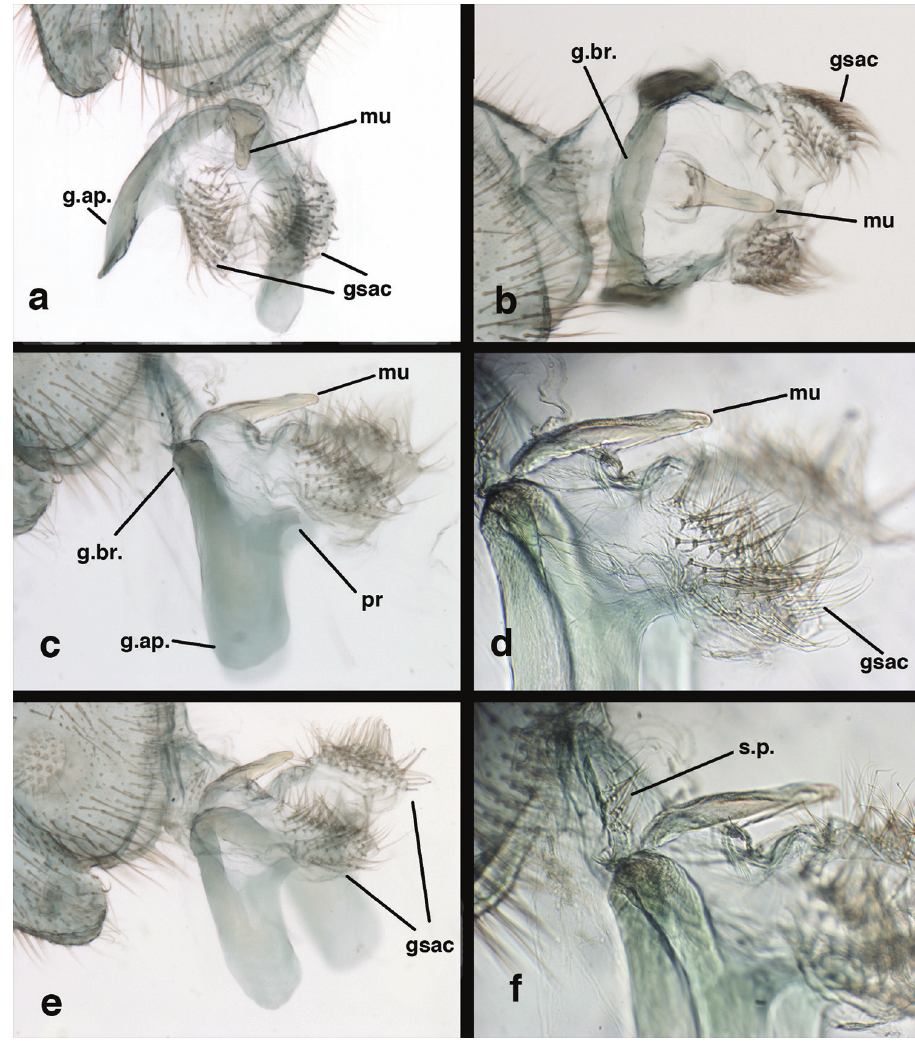
Figure 15. Ungla banksi Tauber, new replacement name: Male genitalia, ( a ) gonarcus, frontal ( b ) gonar- cus, dorsal ( c ) gonarcus, lateral ( d ) gonarcus (partial), lateral ( e ) gonarcus, anterolateral, showing widely separated, paired lobes of gonosaccus ( f ) tip of tergite 9 + ectoproct, with subanal plate above gonarcal bridge gsac gonosaccus g.ap. gonarcal apodeme g.br. gonarcal bridge mu mediuncus pr unarticulated process on frontal margin of gonarcal apodeme s.p. setose subanal plate (Bolivia, Rio Zongo, holotype, MCZ). 0.4 mm wide (ratio, L : W = 5.1 : 1); 3–4 Banksian cells (b cells), 4 b’ cells; 7 inner gra- dates, 6–8 outer gradates, sometimes a middle gradate vein. Hindwing with venation delicate, not swollen, light green, except C, Sc, costal veinlets brown; 12.1–12.4 mm long, 4.4 mm wide (ratio, L : W = 2.7–2.8 : 1), 11–12 radial cells, 2–3 Banksian (b) cells, 4 b’ cells, 5–6 inner gradates, 6–7 outer